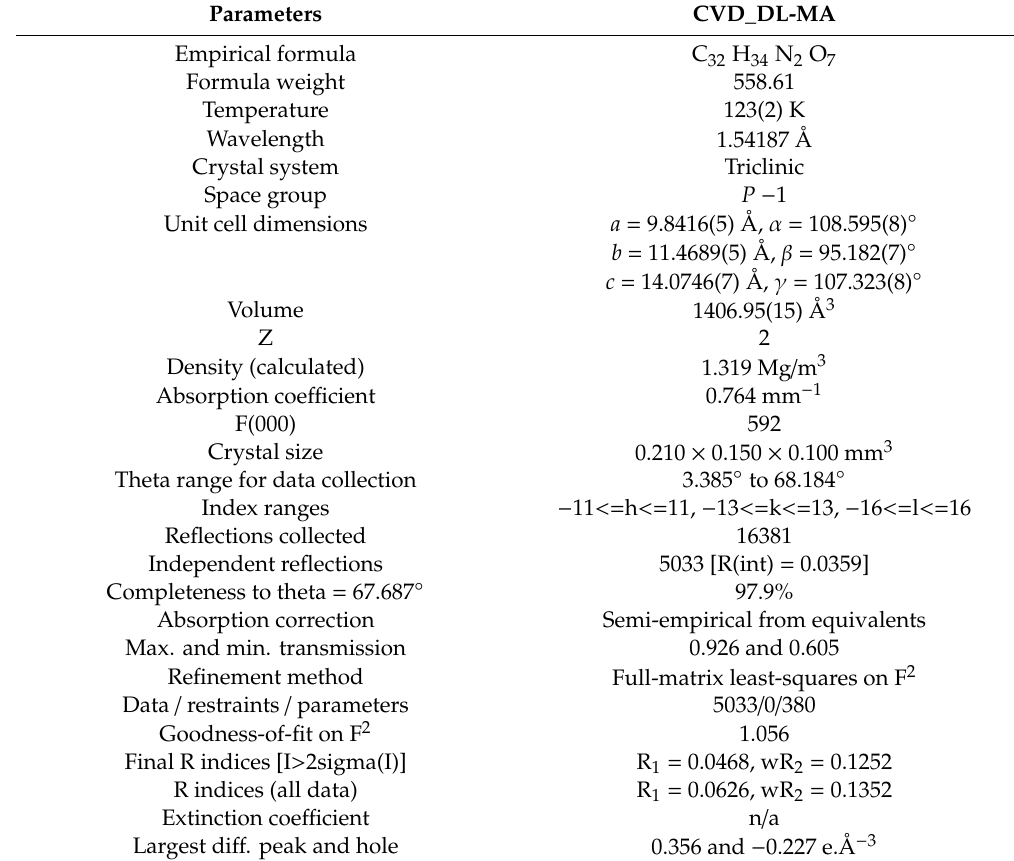
Table 1. Crystallographic data table for the CVD_DL-MA salt.